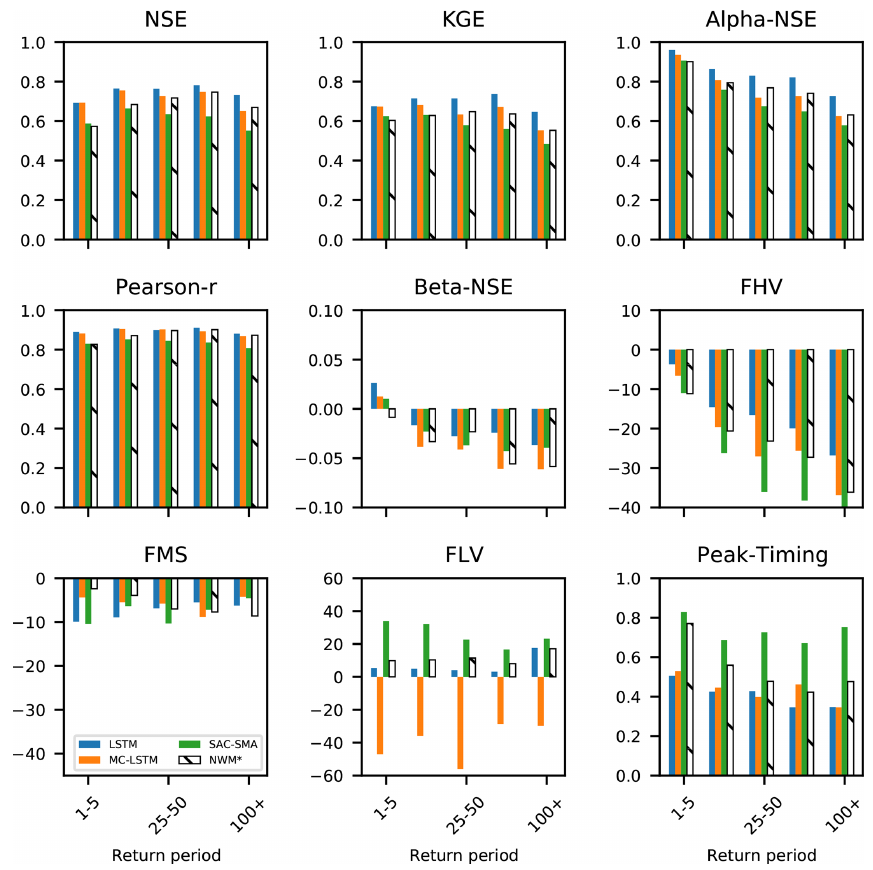
Figure C1. Metrics for training only on a standard time split; the training period was water years 1981–1995, and the test period (shown here) was water years 1996-2014. The total number of samples in each bin is as follows: n = 5969 for 1–5, n = 1260 for 5–25, n = 185 for 25–50, n = 91 for 50–100, and n = 84 for 100 +